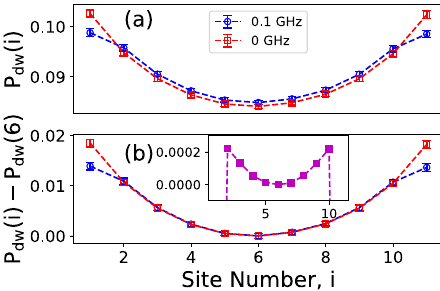
Fig. 7 Domain-wall distribution with different gauge choices. X represents data taken in the gauge which all couplers are antiferromagnetic. Asterisks are averaged over random gauges. Circles are data for the gauge in which all couplers are ferromagnetic. All data in this fi gure have been corrected for background susceptibility.